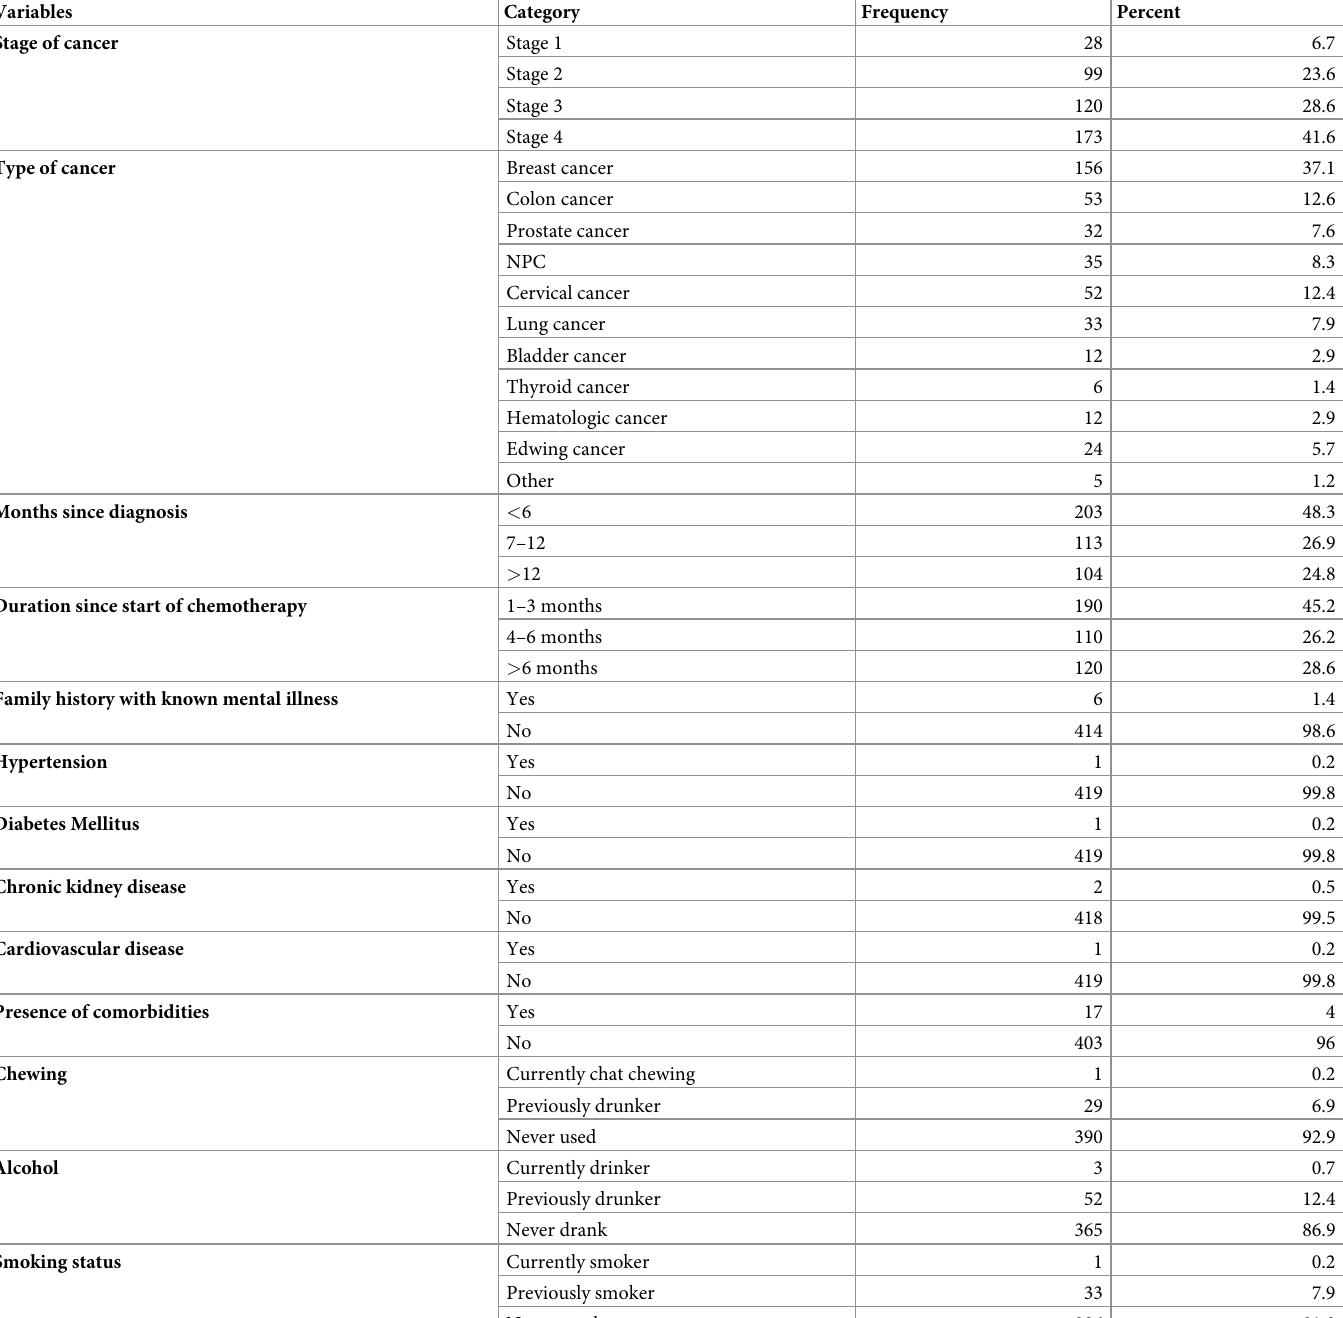
Table 2. Clinical and behavioral characteristics of study participants among adult cancer patients at oncology clinic of TASH, Addis Ababa, Ethiopia,